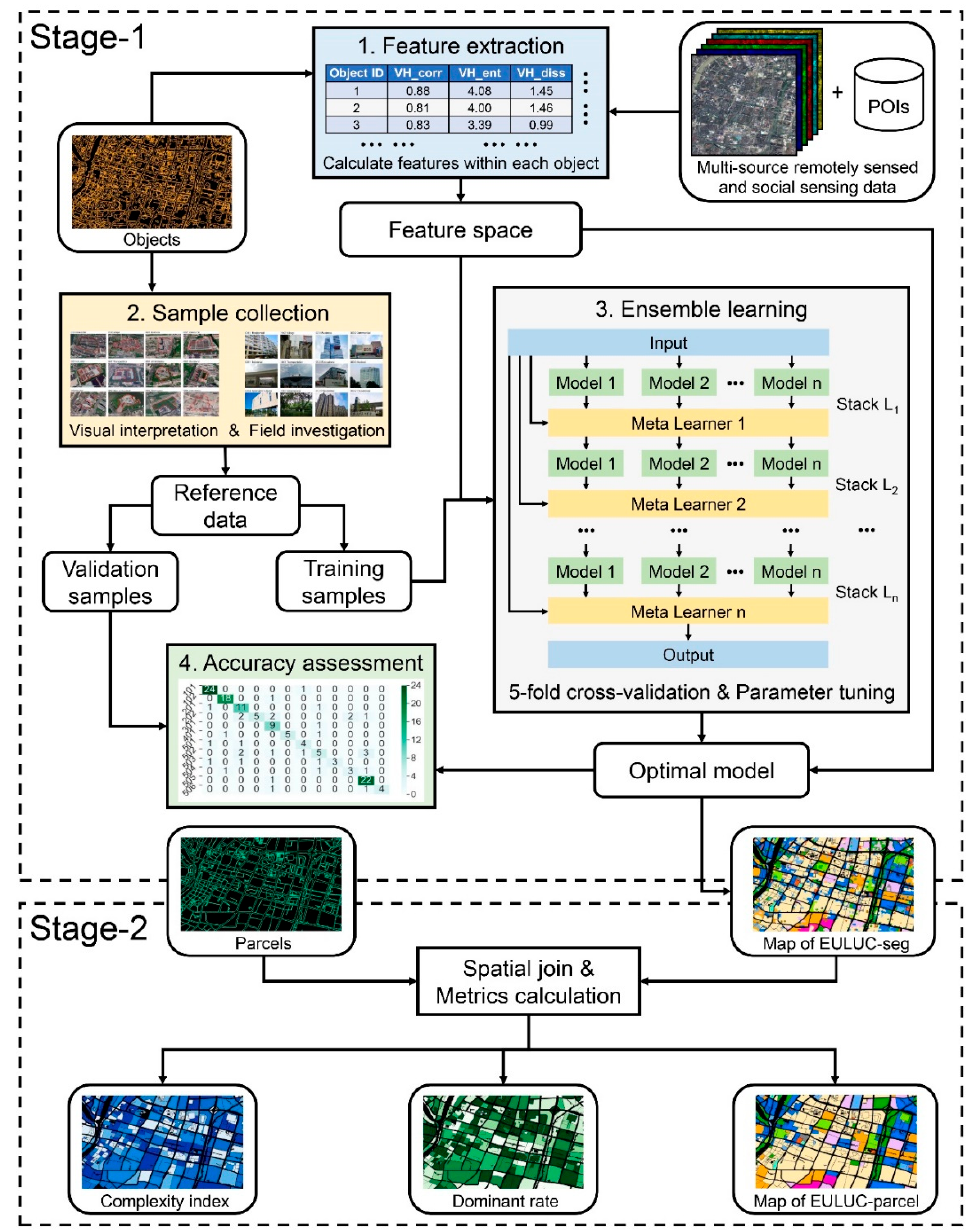
Figure 2. Flowchart of the proposed two-stage urban land use mapping scheme.